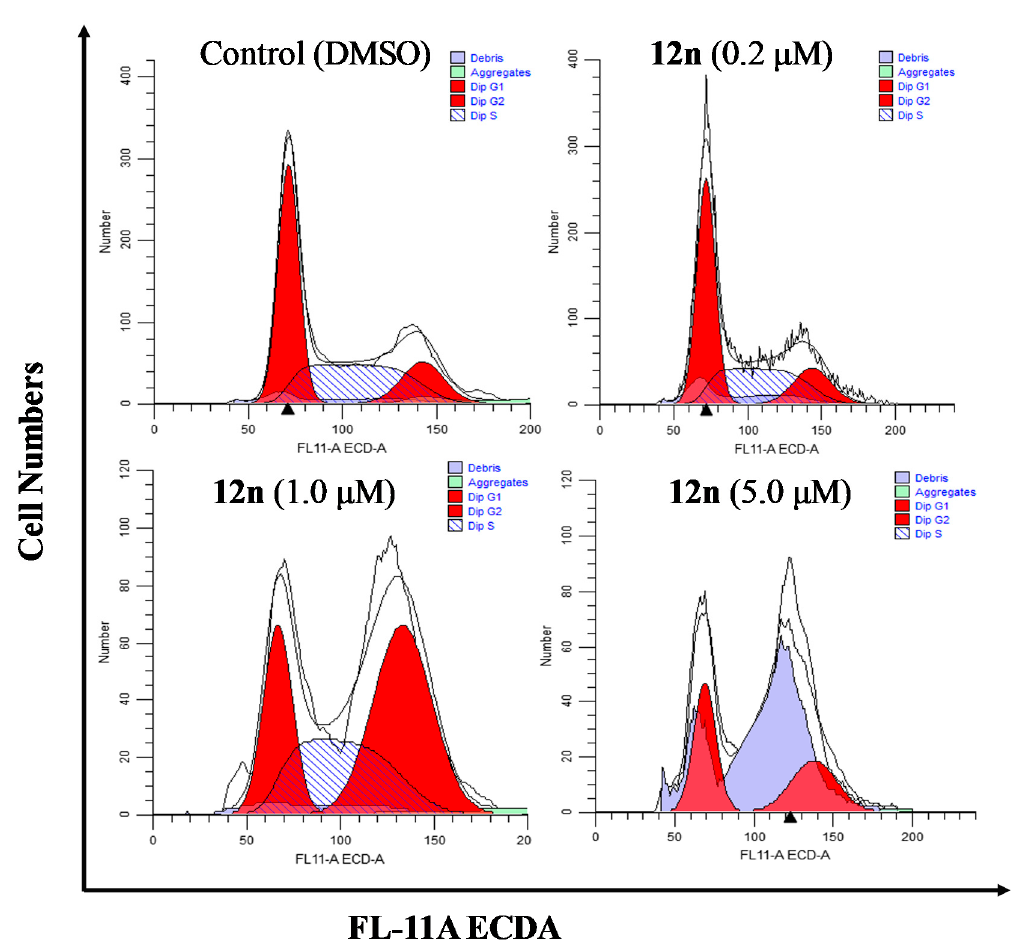
Figure 5. Effects of compound 12n on the cell cycle distribution of PC-3 cells after treatment for 48 h. Table 5. Distribution of the cell cycle after treatment with 12n in PC-3 cells.